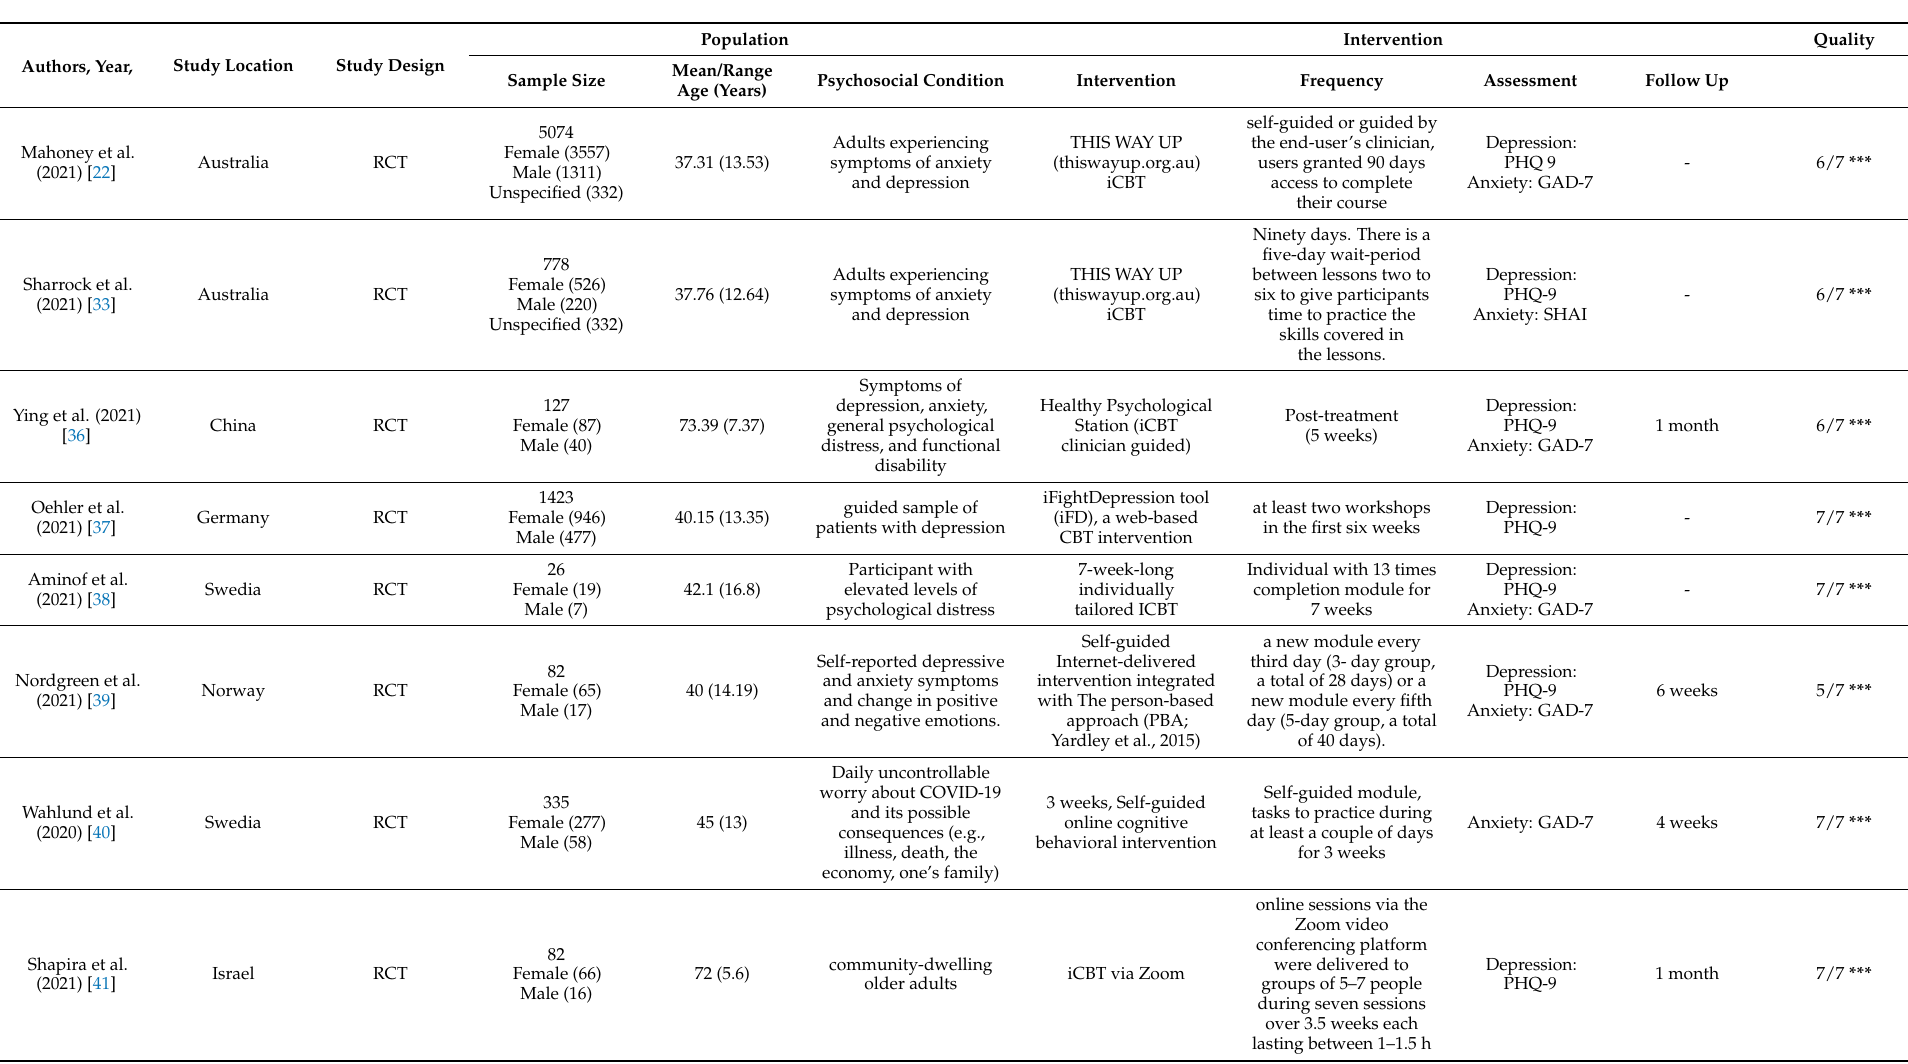
Table 1. Characteristic of included